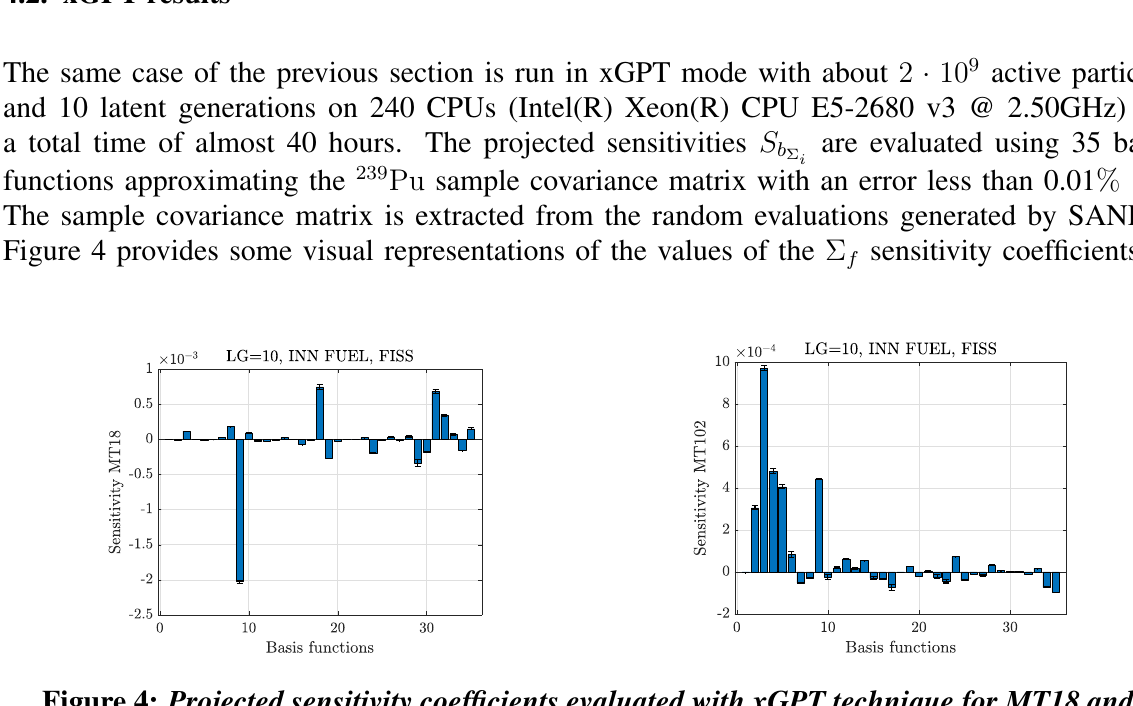
Figure 4: Projected sensitivity coefficients evaluated with xGPT technique for MT18 and MT102.